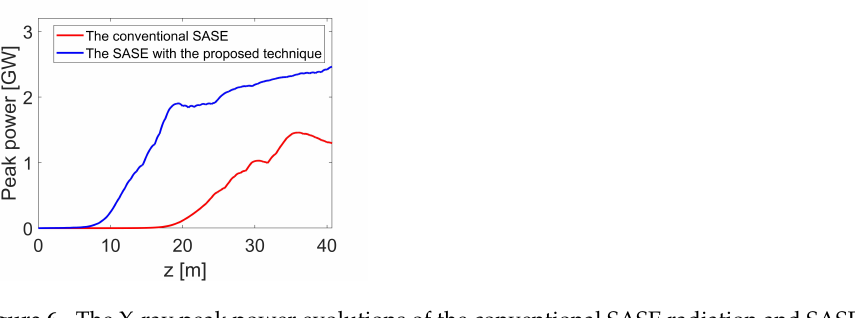
Figure 6. The X-ray peak power evolutions of the conventional SASE radiation and SASE radiation with the proposed